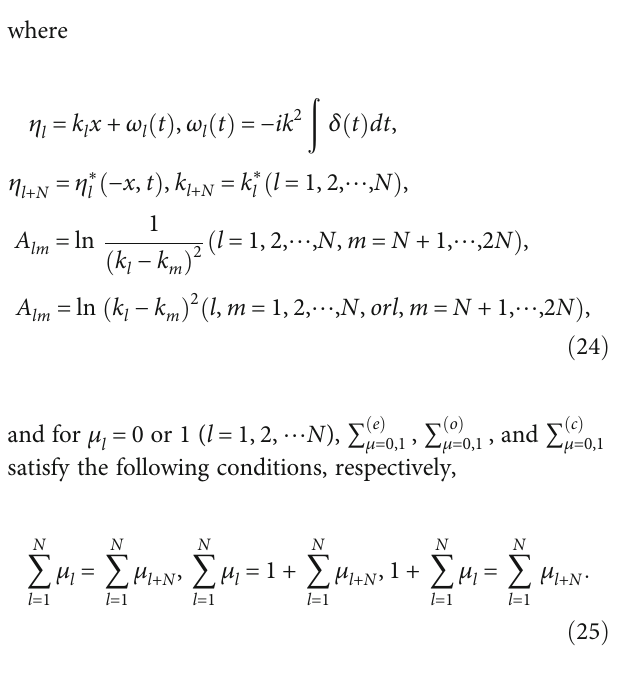
Figure 3: (a) Double spatial-period soliton solution with parameters: k (red), t = 5 (blue), and t = 10